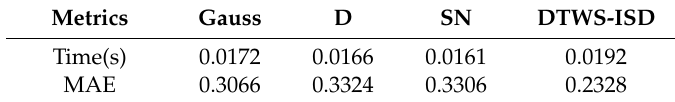
Table 2. Performance comparison between DTWS-ISD and three existing functions.